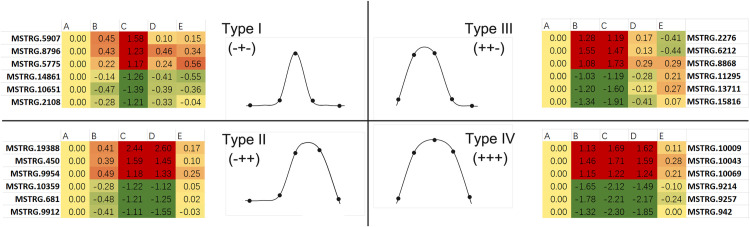
Schematic of gene expression patterns.The log2 (fold change) of gene expression in test group B (12°C), group C (4°C) and group D (12°C) compared with control group A (27°C) are showed in the tables in which green represents downregulation and red represents upregulation. Moreover, significant up- or down-regulation is marked as positive (+), and non-significant expression is labeled as negative (-). The curves display the differential expression of genes in group A, B, C, D, E.